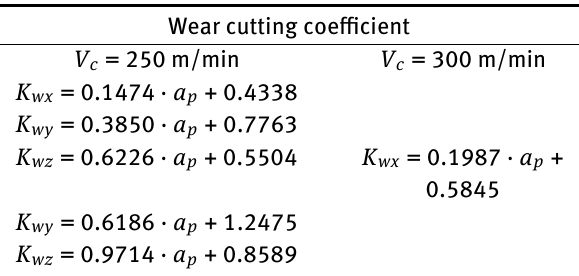
Table 3: The wear coeflcient functions depending on depth of cut. Wear cutting coeflcient